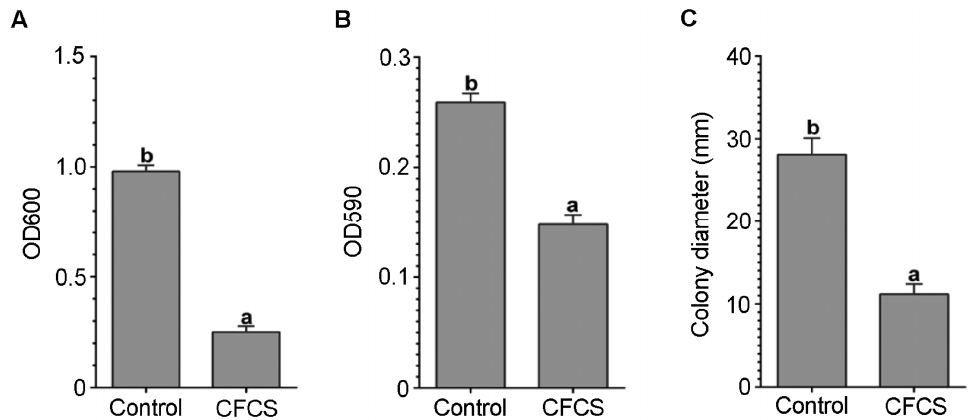
Figure 2. Antibacterial activities of cell-free culture supernatant (CFCS) of Paenibacillus polymyxa ShX301 against Dickeya dadantii CZ1501. ( A ) D. dadantii growth in nutrient broth in microplate wells determined by optical density at 600 nm (OD600). ( B ) Biofilm formed on the surface of microplate wells by D. dadantii during 24-h incubation determined by crystal violet absorbance at 590 nm (OD590). ( C ) Diameter of D. dadantii colonies formed on 0.3% ( w/v ) agar via swimming. Vertical bars represent the standard errors of mean values ( n = 6). Different letters on the bars indicate a significant difference between the treatments at p < 0.05.